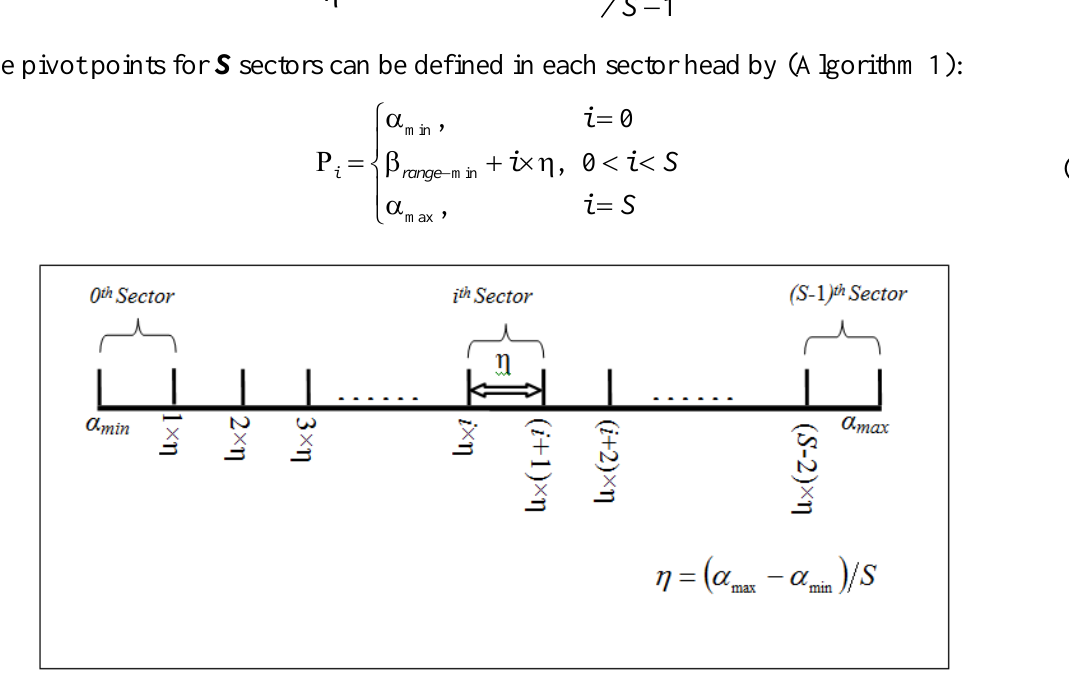
Figure 3. Pivot point generation